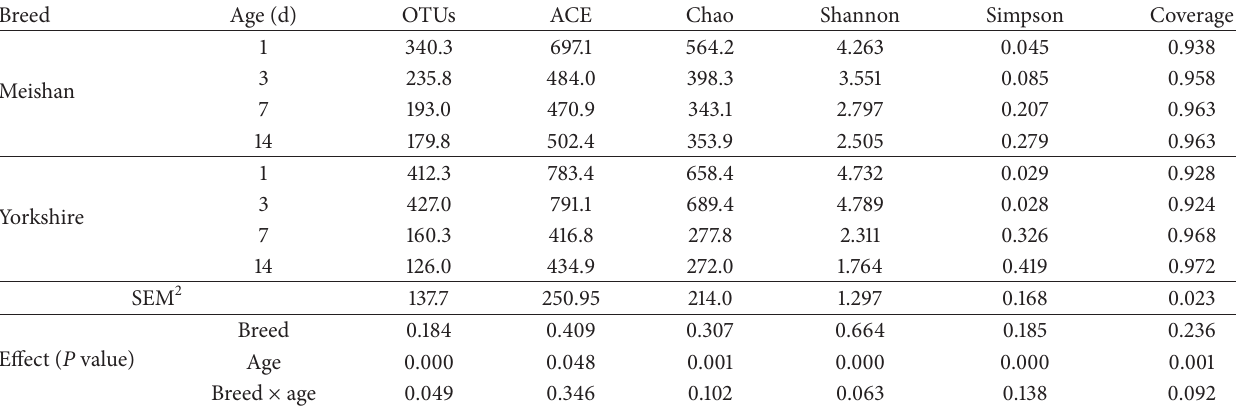
Table 1: Phylotype coverage and diversity estimation of the 16S rRNA gene libraries from faecal methanogens of Meishan and Yorkshire piglets 1 .